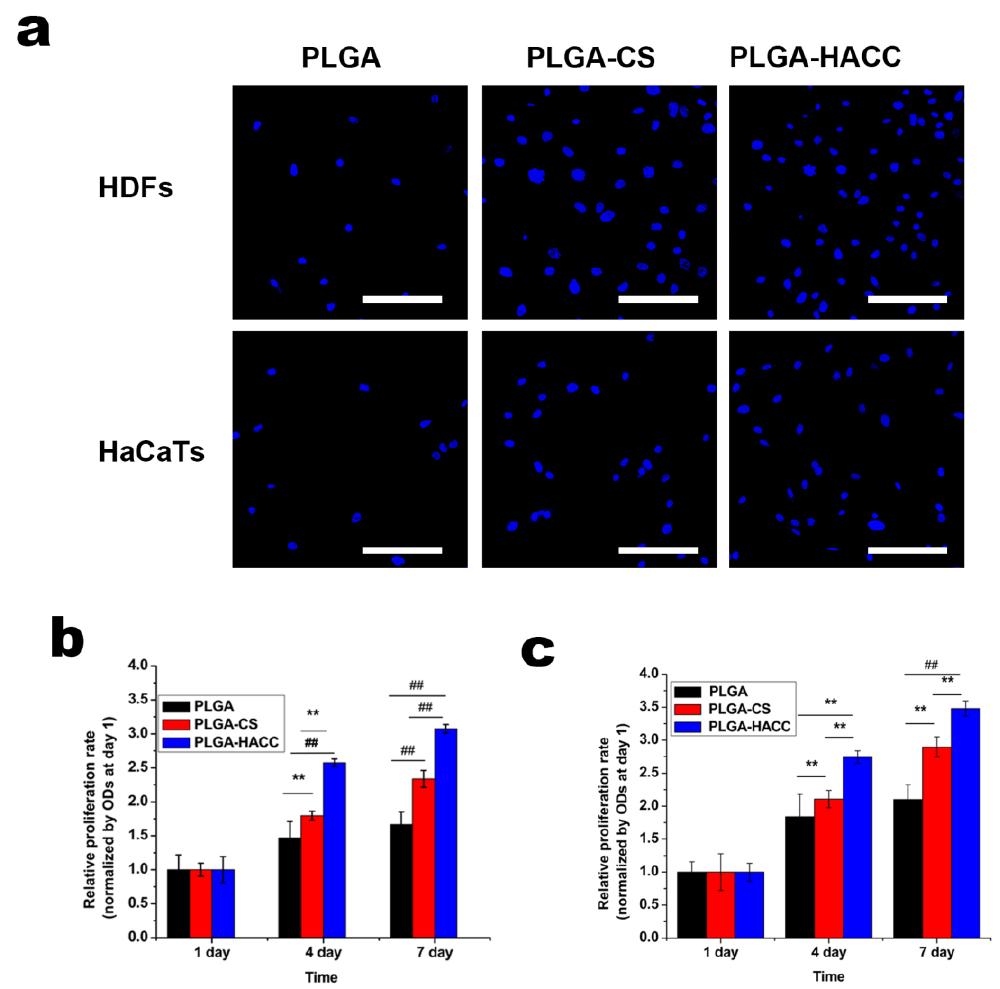
Figure 3. Attachment and proliferation of human dermal fibroblasts (HDFs) and HaCaTs on various fibrous membrane surfaces. Cells stained with DAPI after 6 h of culture ( a ); relative HDFs’ ( b ) and HaCaTs’ ( c ) proliferation rates on various fibrous membranes as measured by the CCK-8 assay; ## indicates p < 0.01, and ** indicates p < 0.05. The scale bar is 50 μm.